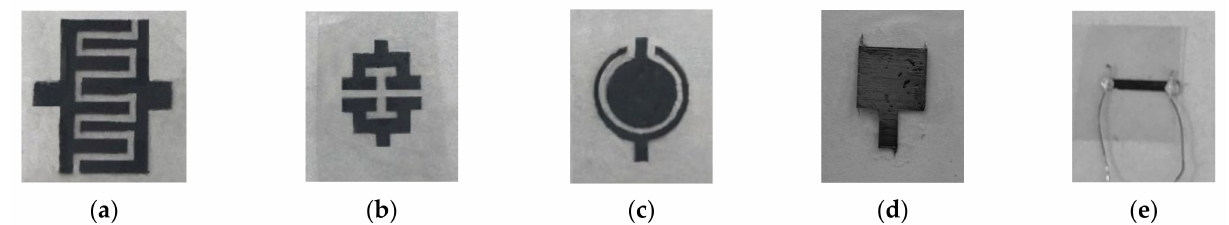
Figure 1. Patterns printed with a stencil on polyethylene terephthalate (PET) with dimensions: ( a )—20.2 × 20 mm 2 ; ( b )—10.5 × 10 mm 2 ; ( c )—20 × 10.5 mm 2 ; ( d )—10.5 × 10 mm 2 ; ( e )—10 × 2 mm 2 with a thickness of 4–6 microns.